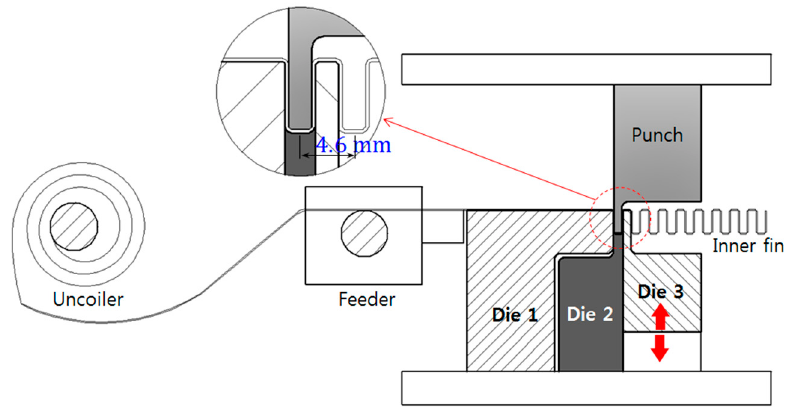
Figure 5. Progressive forming process for manufacturing inner fin.